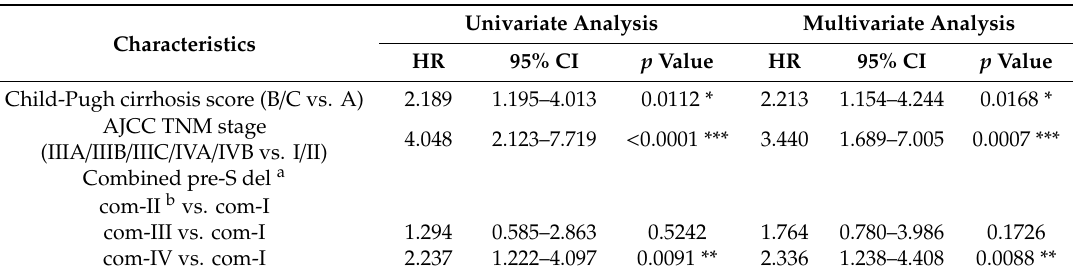
Table 5. Univariate and multivariate analyses of combined pre-S deletion for recurrence-free survival in 75 HBV-related HCC